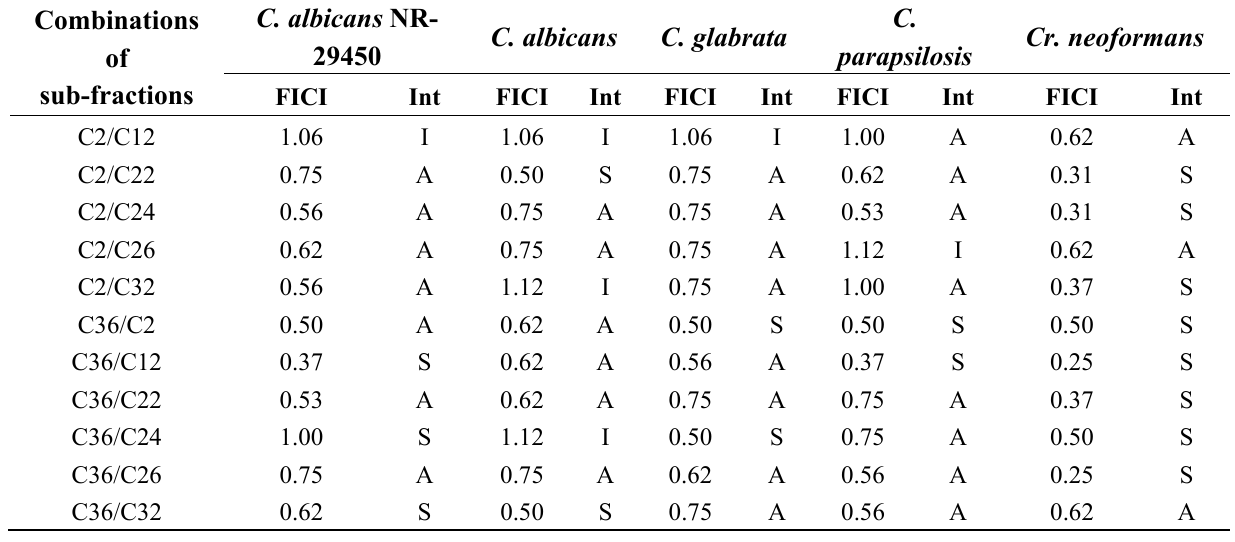
Table 2. Effect of combined sub-fractions on the tested